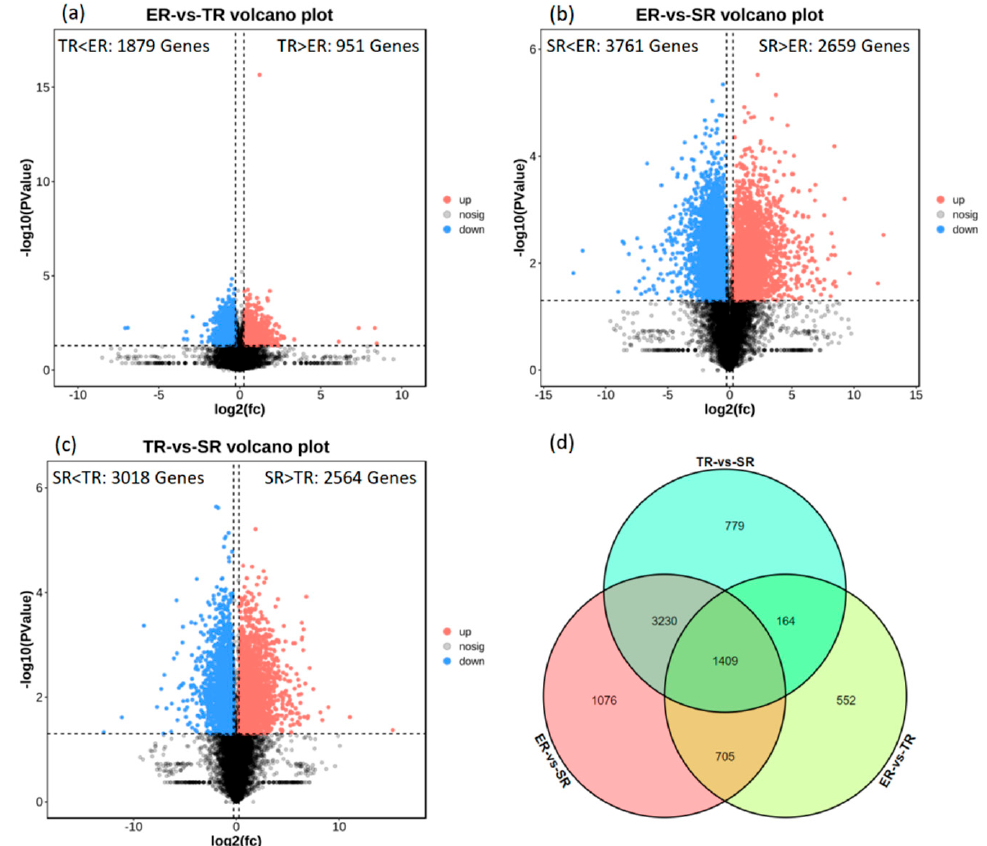
Figure 3. Analysis of DEGs in different samples. ( a – c ) Volcano plots illustrating DEGs between different stipe regions. ( d ) Venn diagram showing DEGs identified from comparison of ER, TR, and SR groups. ER, elongation region; TR, transition region; SR stable region.